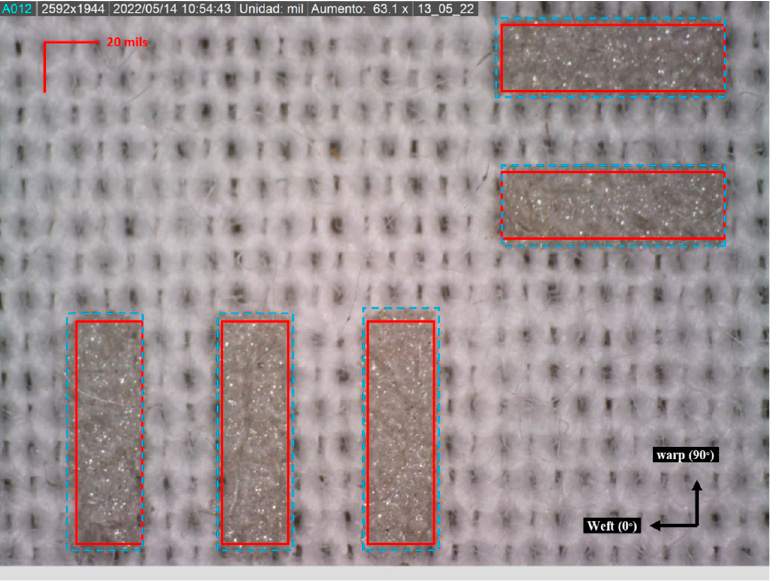
Figure 9. Variation in the land pattern of a PLCC32. The theoretical zones of the pads are represented in red and the real ones in